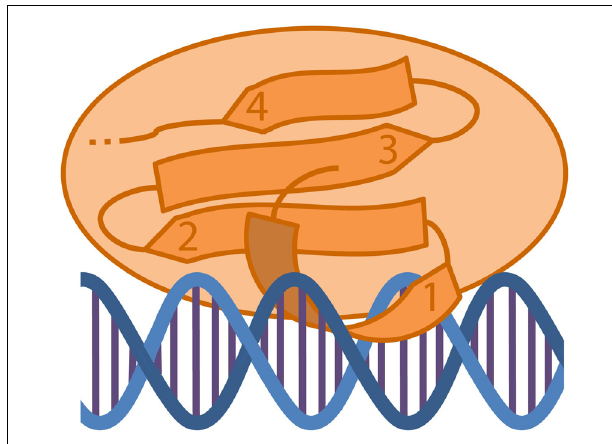
FIGURE 3 | Diagram of aWRKY C-terminal domain interacting with the DNA. The C-terminalWRKY domain consists of a four-stranded antiparallel β -sheet (1–4).The DNA recognition takes place along the major grove by the β 1-strand containing theWRKYQK